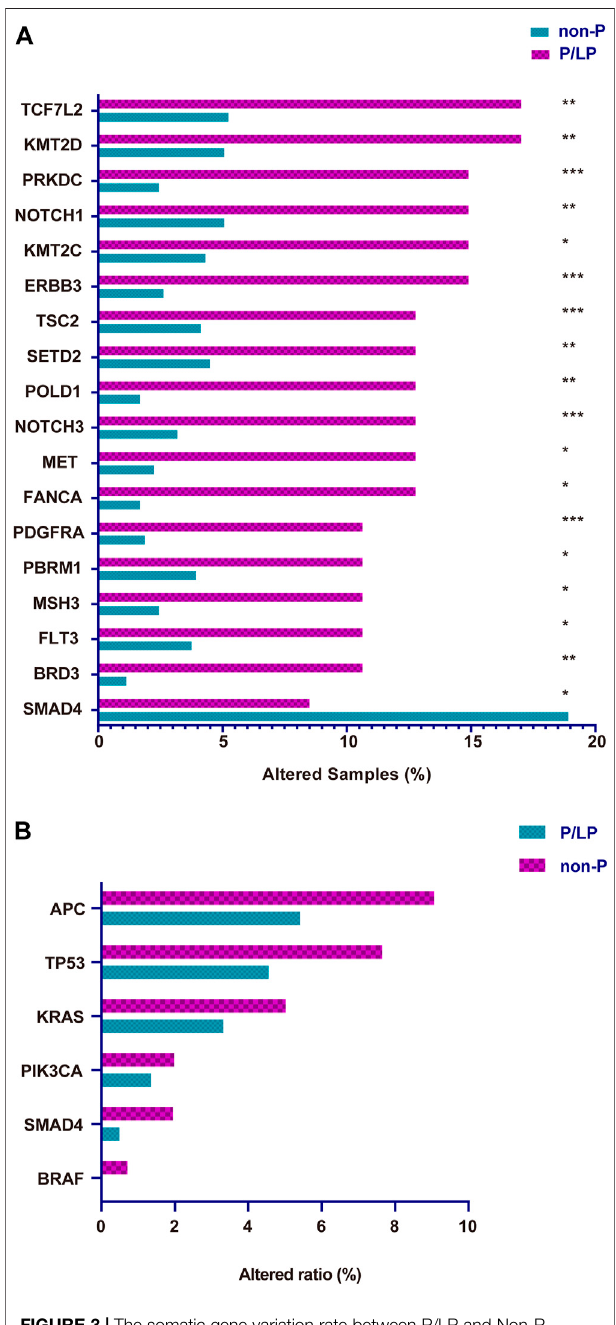
FIGURE 3 | The somatic gene variation rate between P/LP and Non-P groups for all patients in this study. (A) Differential expressing Mutation genes in P/LP and Non-P groups. (B) Comparison of the variation rate (mutational frequency) for driver genes with somatic mutations between P/LP and Non-P groups. P/LP: pathogenic/likely-pathogenic; Non-P: non-pathogenic.